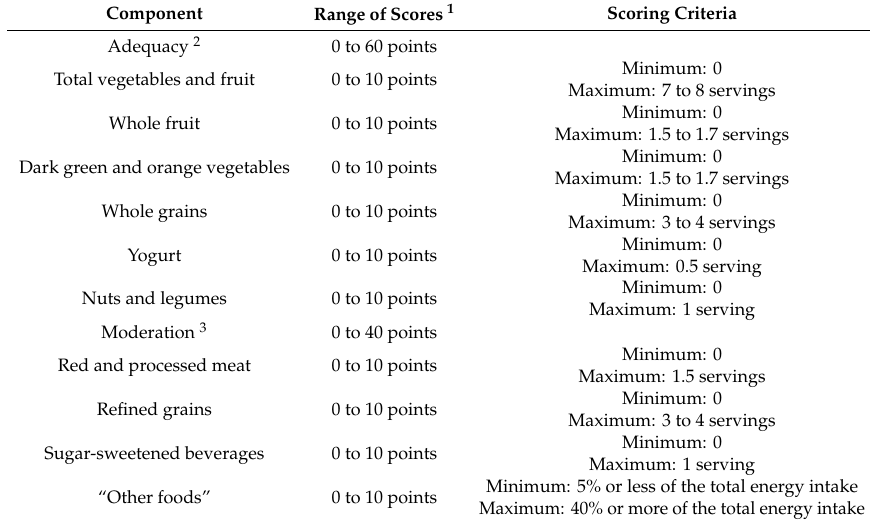
Table 4. Description of the modified version of the Canadian Healthy Eating Index Score (Modified